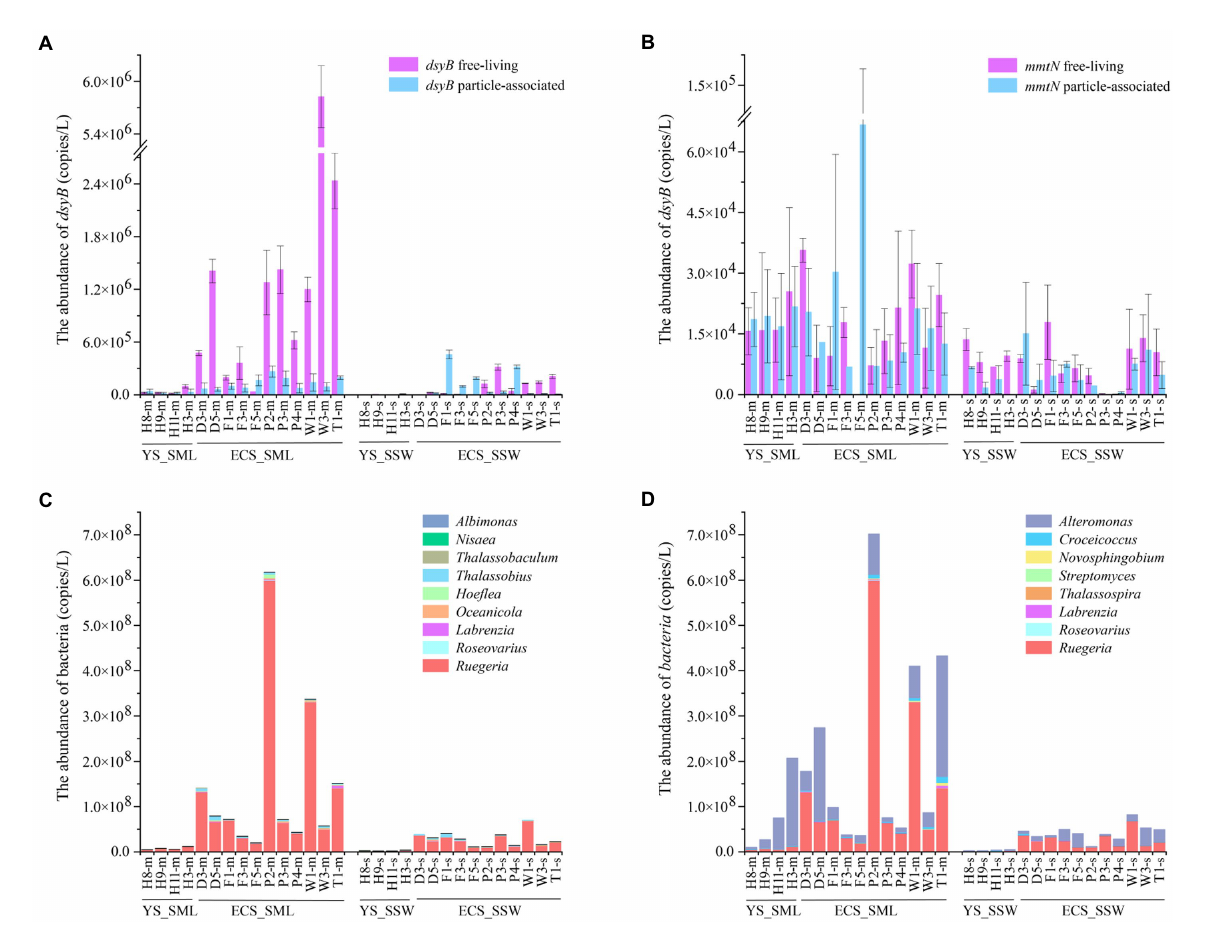
FIGURE 5 The abundance of DMSP-producing organisms and genes in the SML and SSW samples from the East China Sea and the Yellow Sea in summer. (A) , The abundance of dsyB determined by qPCR. (B) , The abundance of mmtN determined by qPCR. (C) , The abundance of genera with representatives known to contain dsyB . (D) , The abundance of genera with representatives known to contain mmtN . Three technical replicates are set for each sample. The SML and SSW samples are indicated with “m” or “s” in their sample names, respectively. YS_SML, the Yellow Sea SML samples; ECS_SML, the East China Sea SML samples; YS_SSW, the Yellow Sea SSW samples; ECS_SSW, the East China Sea SSW